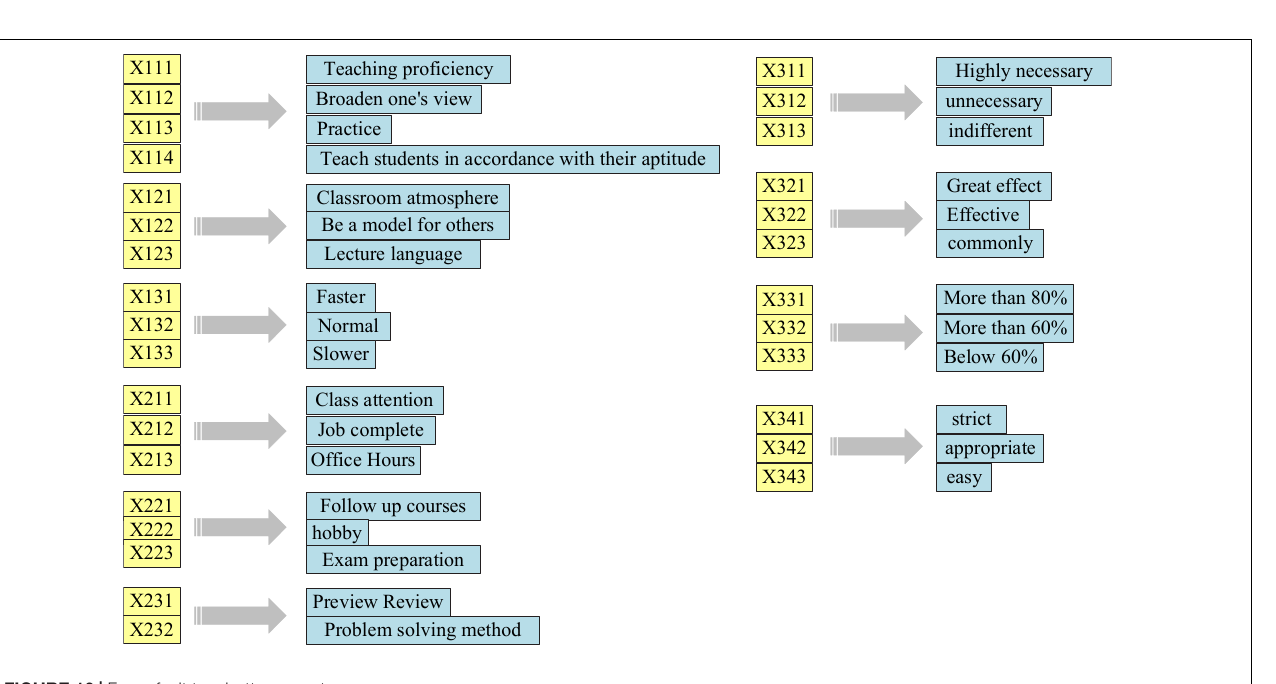
FIGURE 16 | Fuzzy fault tree bottom